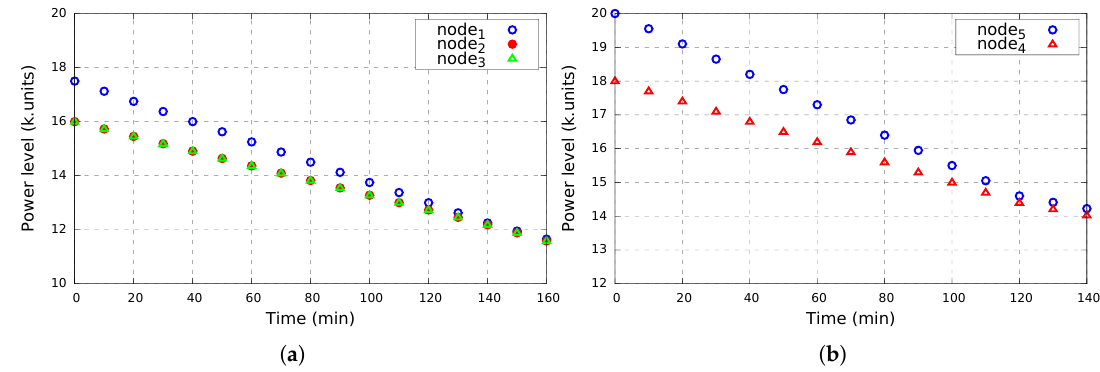
Figure 9. Power consumption per node. ( a ) Power consumption per node inside Room 1; ( b ) Power consumption per node inside Room